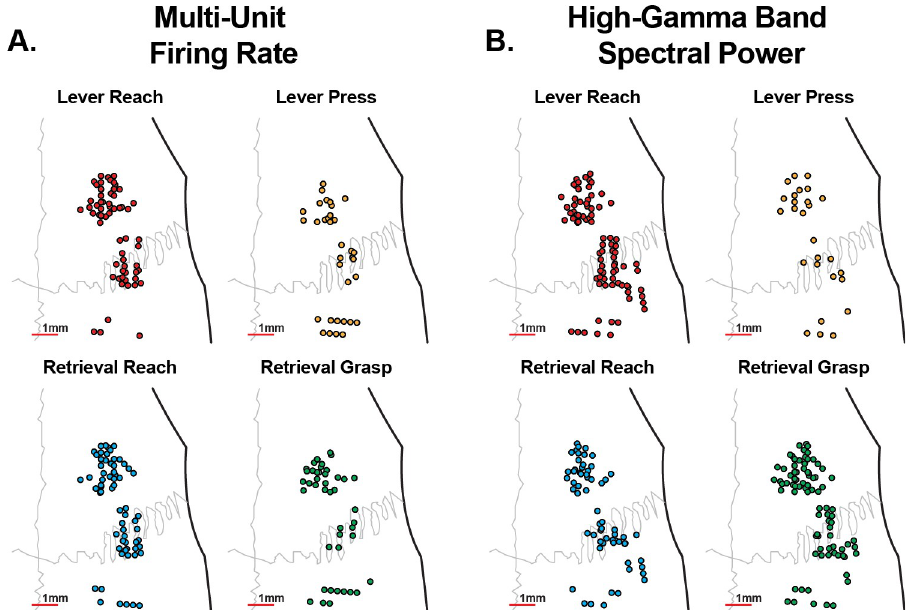
Fig 7. Microelectrode classification. Each microelectrode was classified based upon whether it was significantly modulated by the reach to the lever, the lever press, or not modulated during the lever press. Similarly, each electrode was also classified as modulated when aligned to the reach to the food pellet, when aligned to the grasp of the pellet, or not modulated during the retrieval. Each classification was made using both the multi-unit firing rate ( A ) and high- gamma band (70-110Hz) spectral power ( B ). When examining changes in multi-unit firing rate, more channels were modulated by the reaching movements than either the lever press or grasping movements. When examining changes in high-gamma band power, while more channels were modulated by the reach than the lever press, slightly more channels were modulated by the grasp than the reach to the pellet.